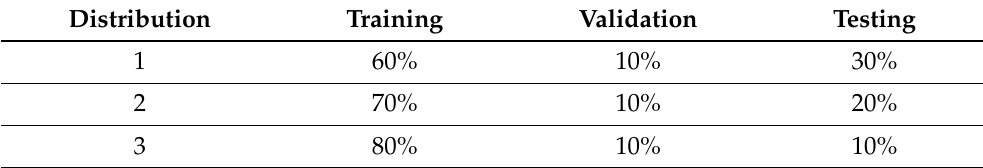
Table 3. Data distribution between training, validation and testing.